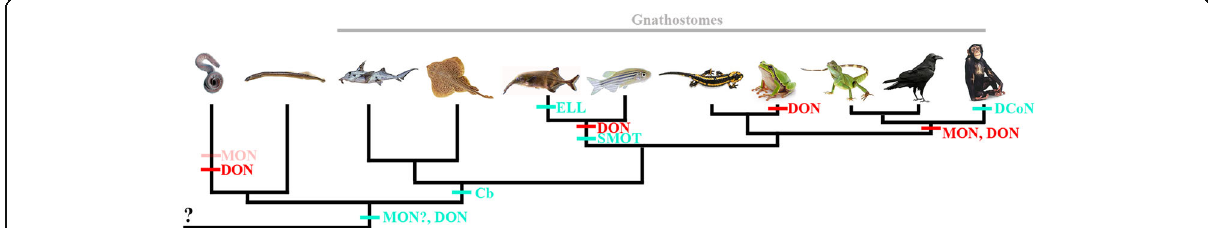
Fig. 6 Vertebrate phylogeny showing the presence of the cerebellum and cerebellum-like structures. Presence of structures is marked by blue, and loss is marked by red. Light red in the hagfish lineage represents a partial loss of the MON. From left to right, animals are representatives from Agnatha, Holocephali and Elasmobranchii (Chondrichthyes), Mormyridae and Cyprinidae (Actinopterygii), Urodela and Anura (Amphibia), Reptilia, Aves, and Mammalia. Cb , cerebellum; DCoN , dorsal cochlear nucleus; DON , dorsal nucleus; ELL , electrosensory lateral lobe; MON , medial nucleus; SMOT , stratum marginale of the optic